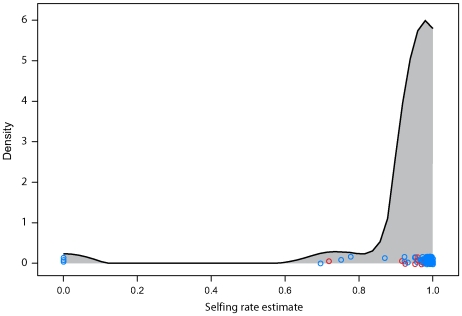
Estimated selfing rate per field site.Individual dots are specific field sites. North American sites are in red. The curve is a smoothed kernel density.